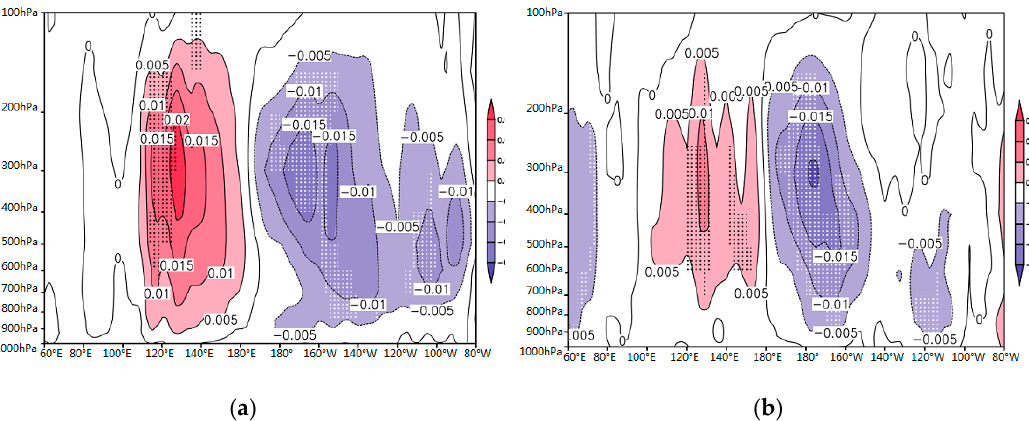
Figure 7. Composite anomalies of longitude–pressure cross-sections of vertical velocity (units: hPa·s − 1 ) averaged along 15° S–15° N during DJF 1979–2016 for the ( a ) spring and ( b ) summer El Niño events. Dotted areas indicate statistically significant vertical velocity at the 95% confidence level, based on the Student’s t -test.